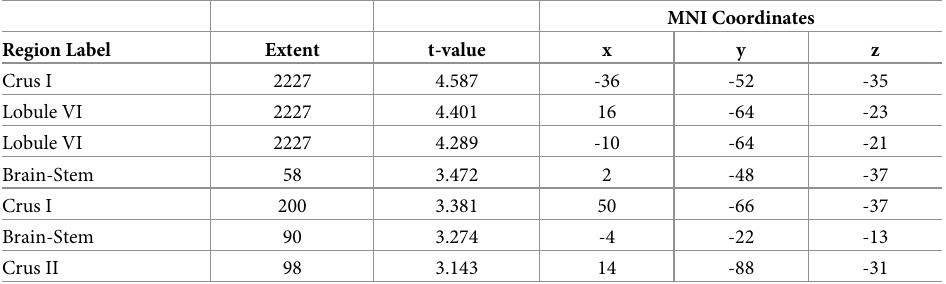
Table 4. Deactivated regions that exhibited a significant negative correlation with performance (p < .05